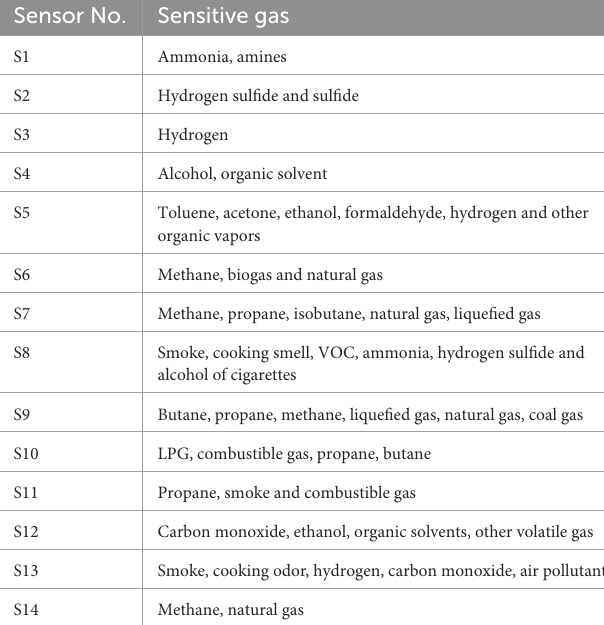
TABLE 1 Detection of flavor component corresponding to sensors. Sensor